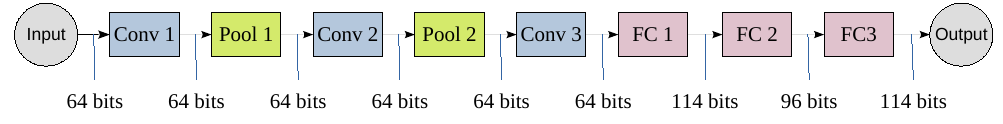
Figure 3. Streaming Architecture. Each CNN layer is mapped into a hardware block, and the hardware blocks are connected to each others via stream channels. The bitwidth of each stream is shown on this